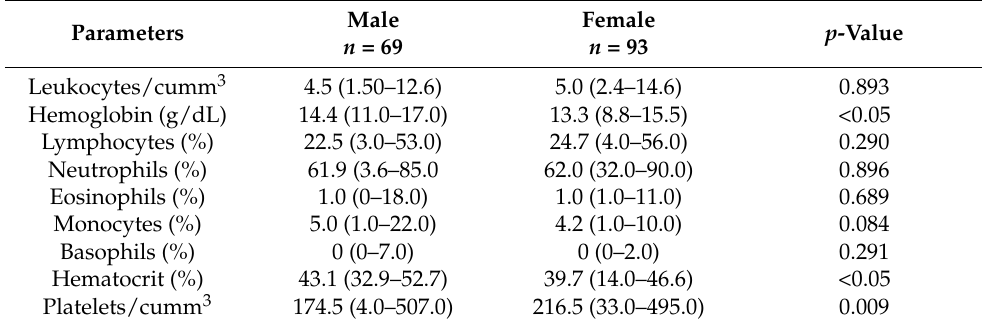
Table 5. Hematological findings in CHIKV-infected patients (N =